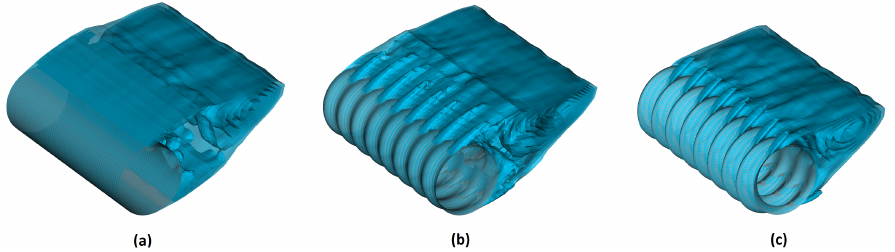
Figure 17. Iso − surfaces of mean streamwise velocity at a near zero value ( U ≤ 10 − 3 ), showing how the flow separation at valleys occurs by means of “ejections − like” events. The three simulated cylinders are shown: baseline ( a ), A03 ( b ) and A11 ( c ).